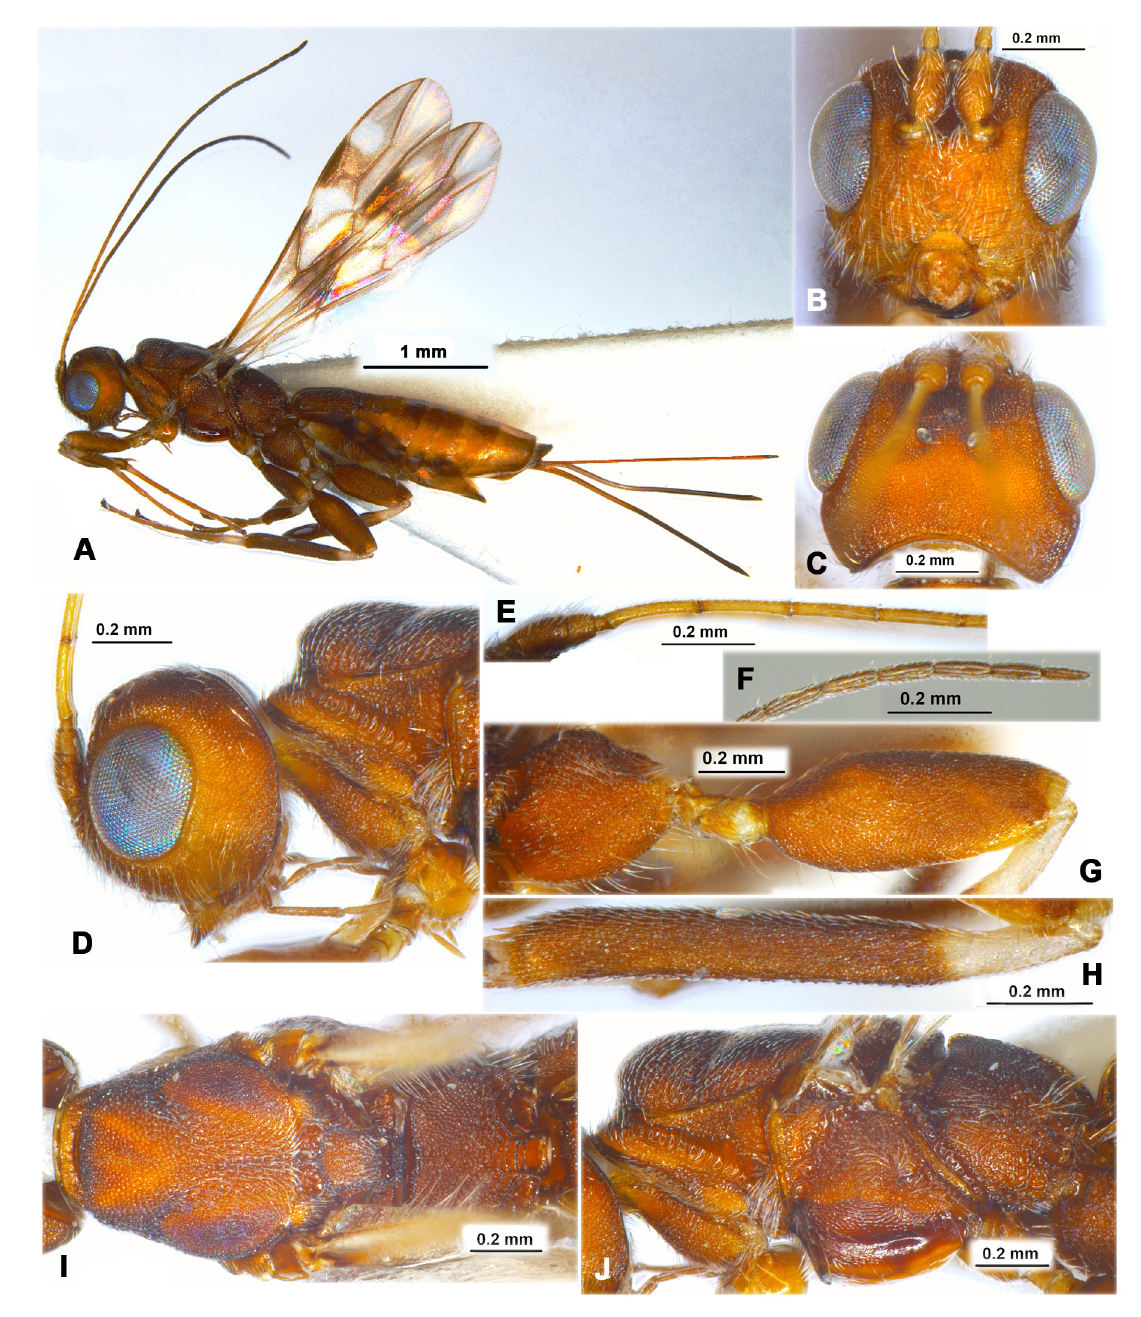
Fig. 36. Hemidoryctes carbonarius postfurcalis Belokobylskij subsp. nov., holotype, ♀ (RMNH). A . Habitus, lateral view. B . Head, front view. C . Head, dorsal view. D . Head and anterior part of mesosoma, lateral view. E . Basal segments of antenna. F . Apical segments of antenna. G . Hind coxa and femur. H . Hind tibia. I . Mesosoma, dorsal view. J . Mesosoma, lateral